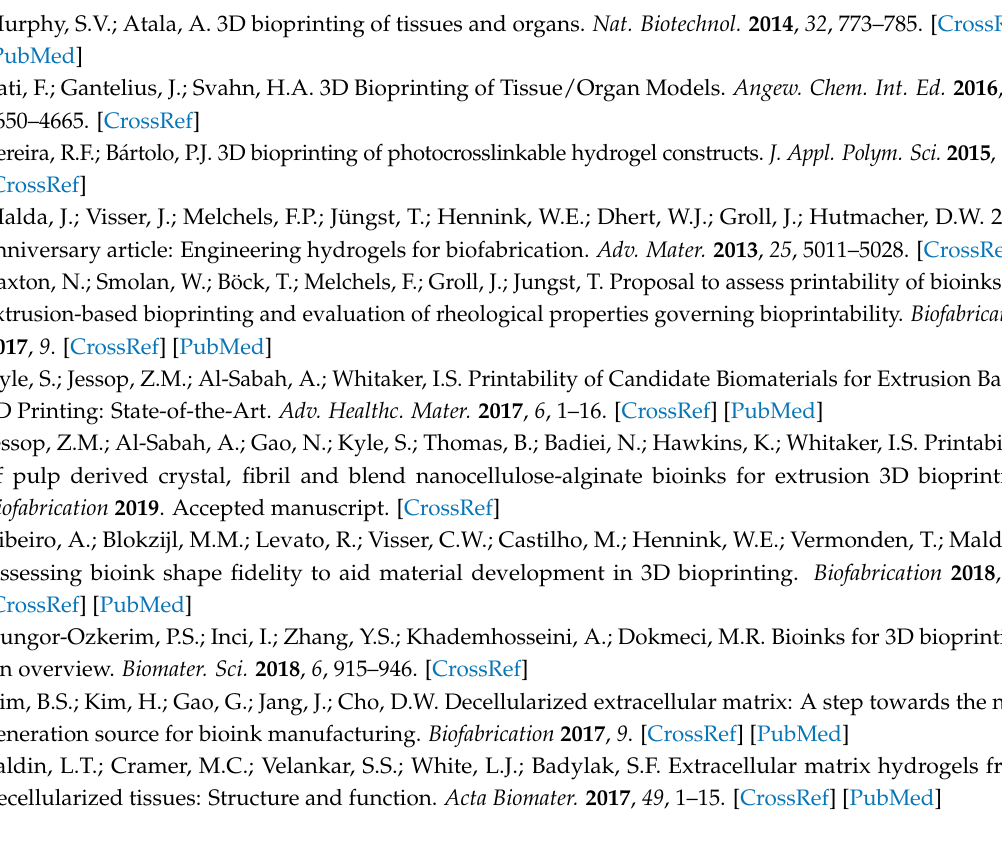
Figure S1: Intensity versus distance from source plot for the irradiation device, Figure S2: Rheological time sweep before and after irradiation, Figure S3: Outlet velocity and velocity profiles simulated for different nozzles at varying extrusion pressures, Table S1: Comparison of similar reported bioinks in terms of rheological parameters and crosslinking strategy